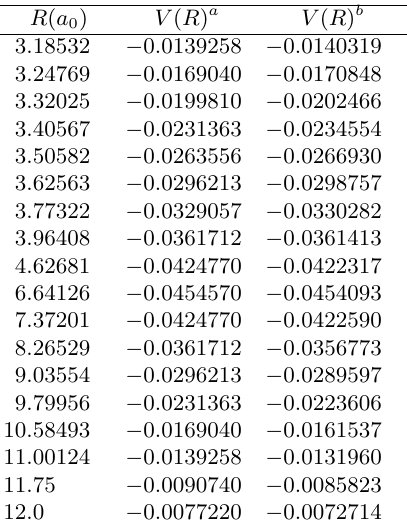
Table 1. Interaction potential energies, Table 2. Interaction potential energies,